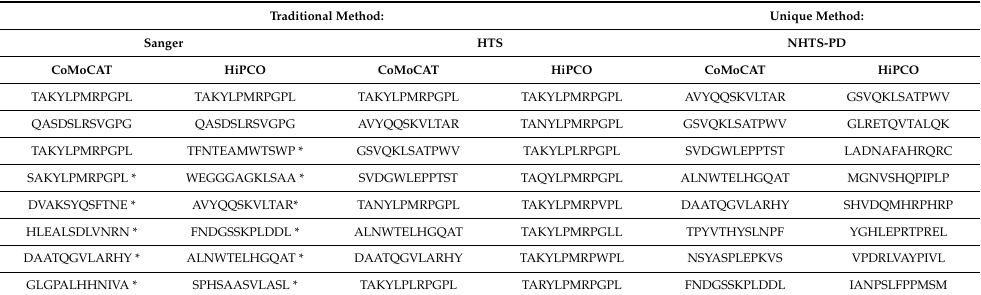
Table A1. Sequencing results for round 5 of traditional Sanger and traditional high throughput methods compared to round 5 of NHTS-PD 1 .